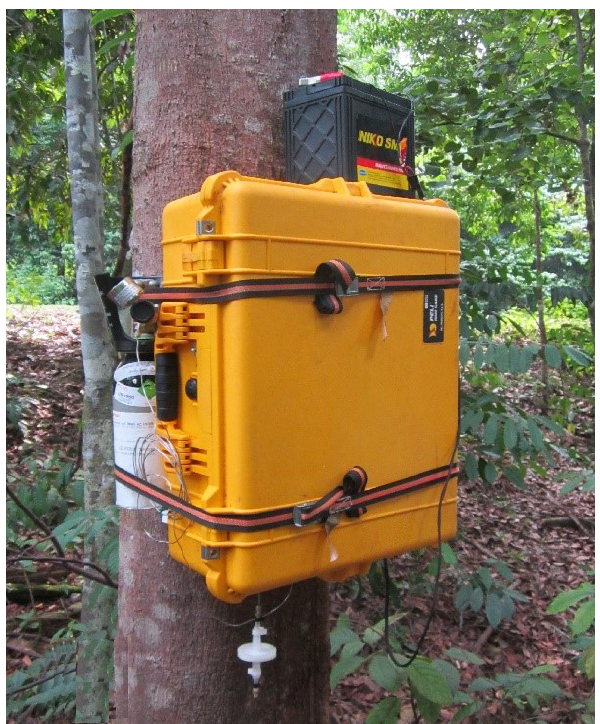
Figure 13. iDirac deployed in a tropical forest environment.